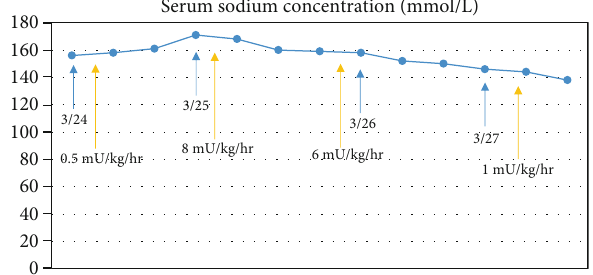
Figure 2: Serum sodium levels throughout fi rst few days of admission. Blue arrows represent dates of hospital stay. Note the peak value of 171mmol/L on day 2 of admission (3/25) with eventual decline after initiation of Furosemide with Vasopressin. Concurrent Vasopressin dosing is evidenced by yellow arrows. Note the initiation at 0.5mU/kg/hr on 3/24, with a maximum infusion rate of 8mU/kg/hr on 3/25, and eventual decline in dosing starting